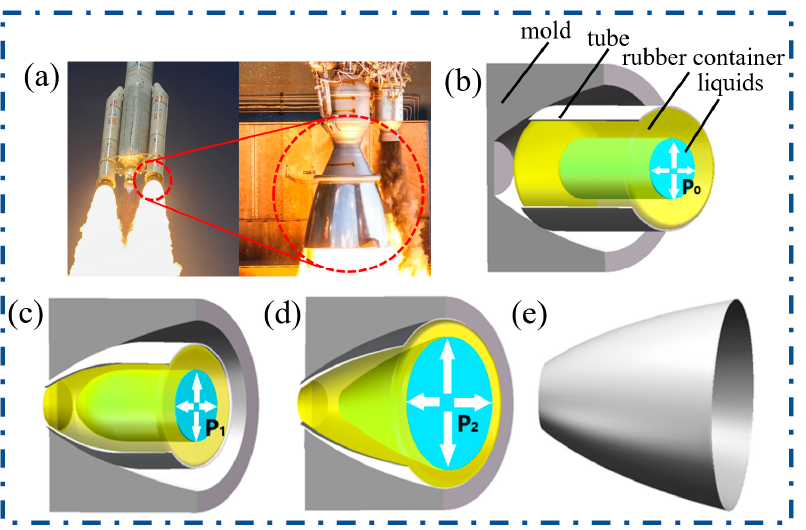
Figure 1. Nozzle of rocket and schematic of TUBG. ( a ) The rocket nozzle, ( b ) The schematic of TUBG with initial internal pressure P 0 , ( c )The tube after upsetting with higher internal pressure P 1 , ( d ) The tube after bulging with much higher internal pressure P 2 , ( e ) The perfectly formed rocket nozzle.